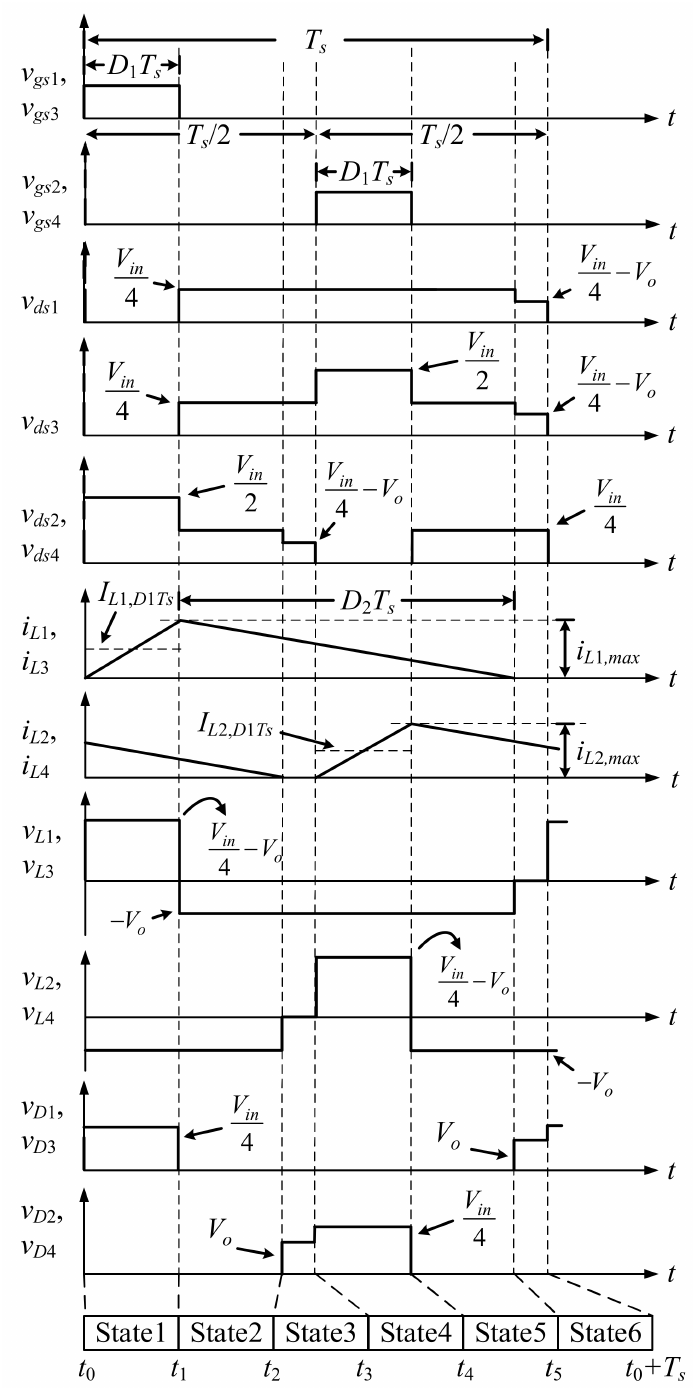
means the voltage across the i-th switch during the y-th state, whereas v Di , statey means the voltage across the i-th diode during the y-th state.